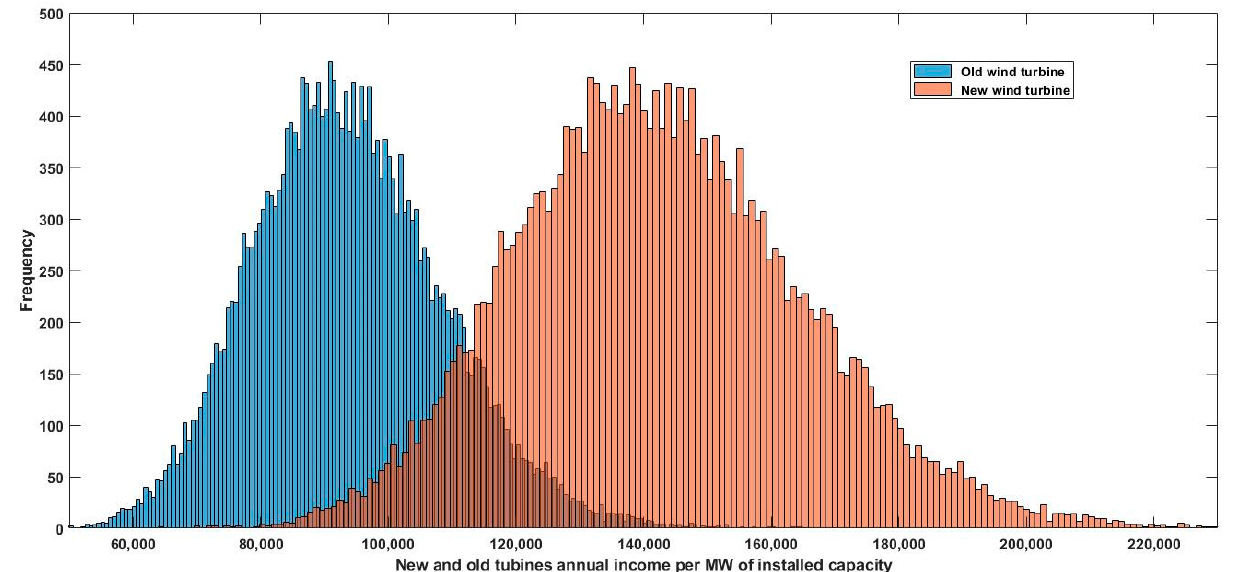
Figure 9. Annual income per MW of installed capacity for new and old turbines. Table 9 shows some statistical distributions in thousands of Euros per year and MW of installed capacity. The expected figure for an old turbine is € 93.66 K and for a new one € 142.43 K. In 80% of cases the annual income is between € 75.43 K and € 113.07 K for an old turbine and between € 114.71 K and € 171.95 K for a new one. Table 9. Income (k € ) per MW of installed capacity.